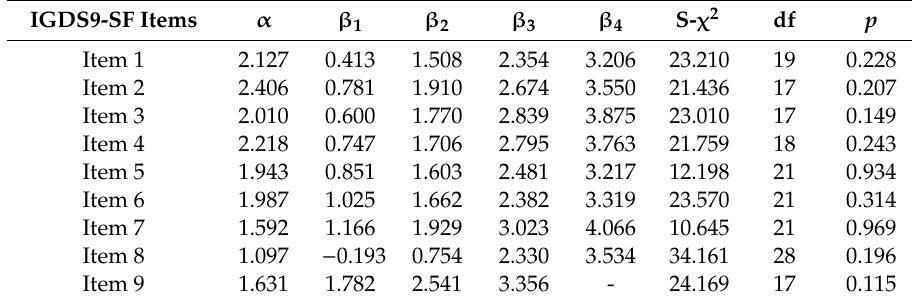
Table 2. Item statistics for the graded response model (GRM) across all items of the Spanish Internet Gaming Disorder Scale-Short Form (IDGS9-SF).